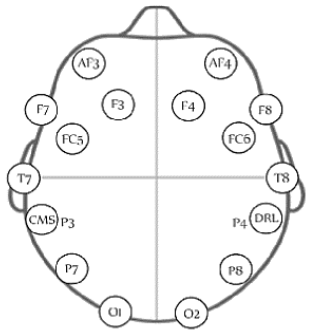
Figure 1 . The distribution of the 14 electrodes of the used EEG headset [30]. Figure 1. The distribution of the 14 electrodes of the used EEG headset